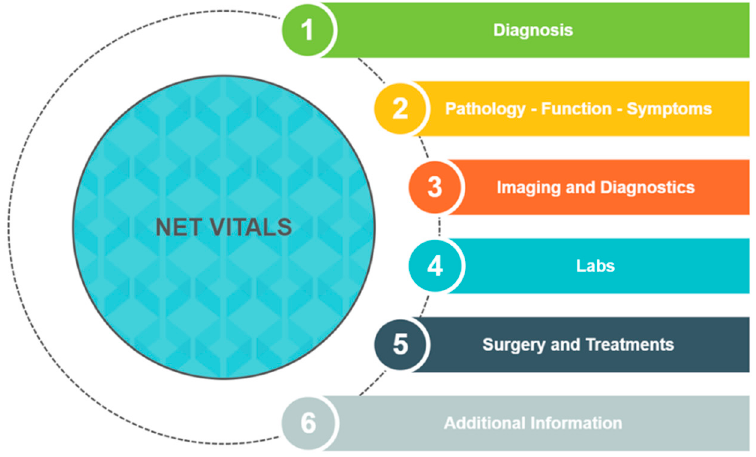
Figure 1. Sections of NET VITALS.